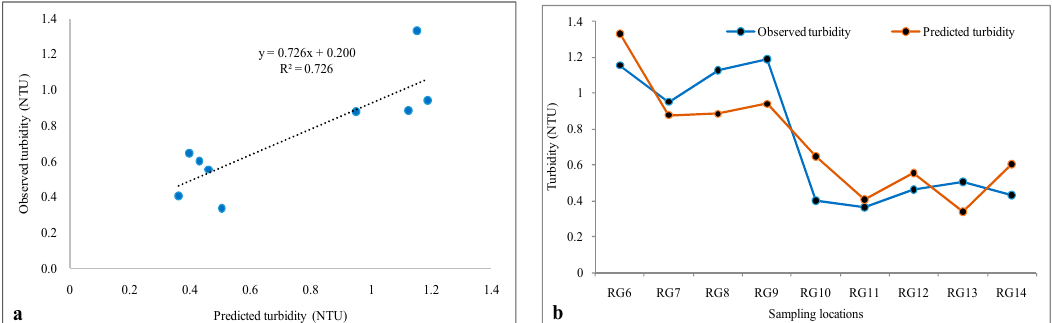
Figure 7. ( a ) Scatter plots and ( b ) line graphs shows the comparison of observed and satellite-retrieved Figure 7. ( a )Scatter plots and ( b ) line graphs shows the comparison of observed and turbidity values at nine sampling sites from the Ramganga River in November 2014. satellite-retrieved turbidity values at nine sampling sites from theRamganga River in November 2014.